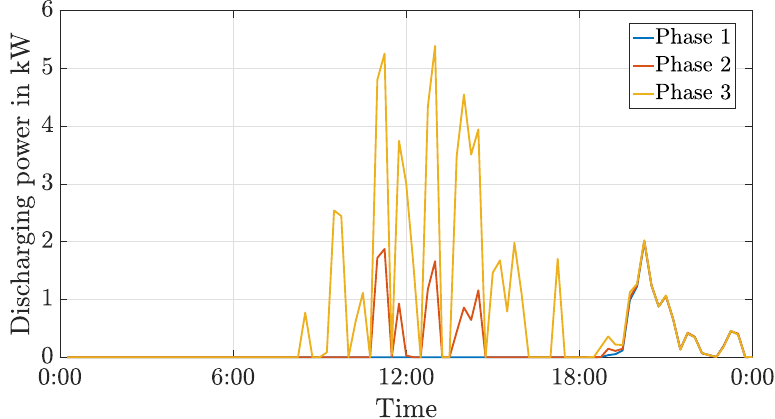
Figure 15. Discharging power of the battery system per phase.